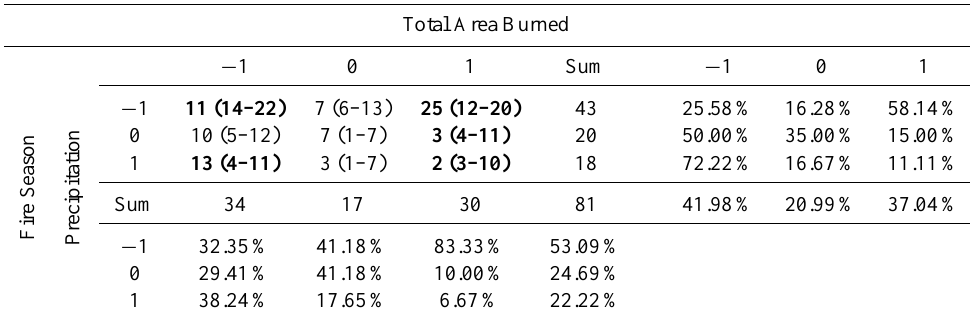
Table 5. Cross-tabulation results between area burned and fire season precipitation. The Monte Carlo randomization confidence limits are in parentheses. Values in bold are statistically significant.